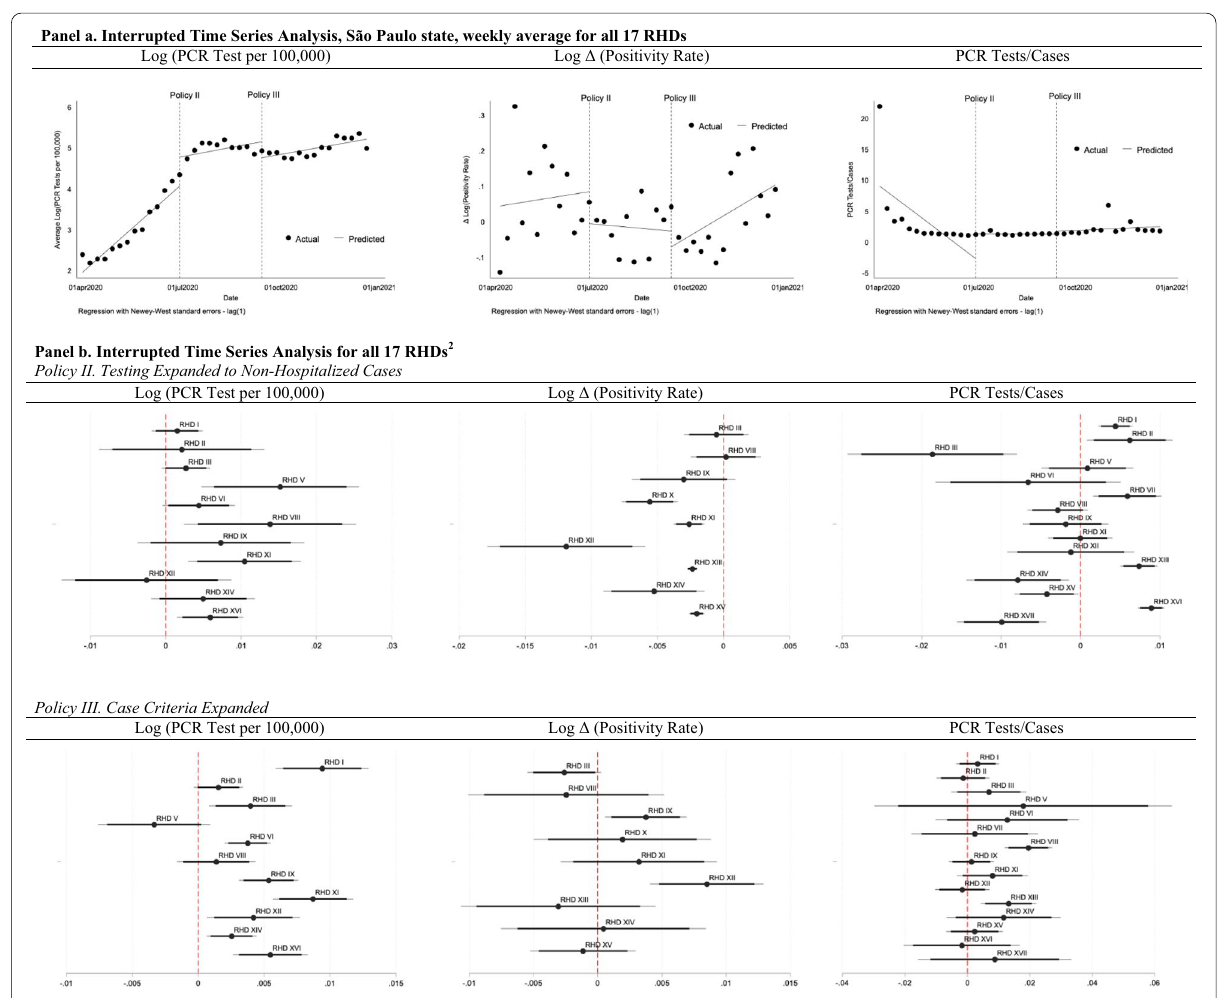
Fig. 3 Segmented Regression for the RT-PCR Testing Policies in the Public Health Network. Notes Data from Public Health Network of São Paulo State, Brazil and in each RHD from March 29, 2020, to December 26, 2020. The figure reports the coefficients and 95% and 90% confidence interval of the post intervention linear trend estimated via interrupted time series analysis for Policy II (Testing Expanded to Non-Hospitalized Cases) and Policy III (Case Criteria Expanded). We excluded from the analysis the RHDs in which serial correlation was detected using the